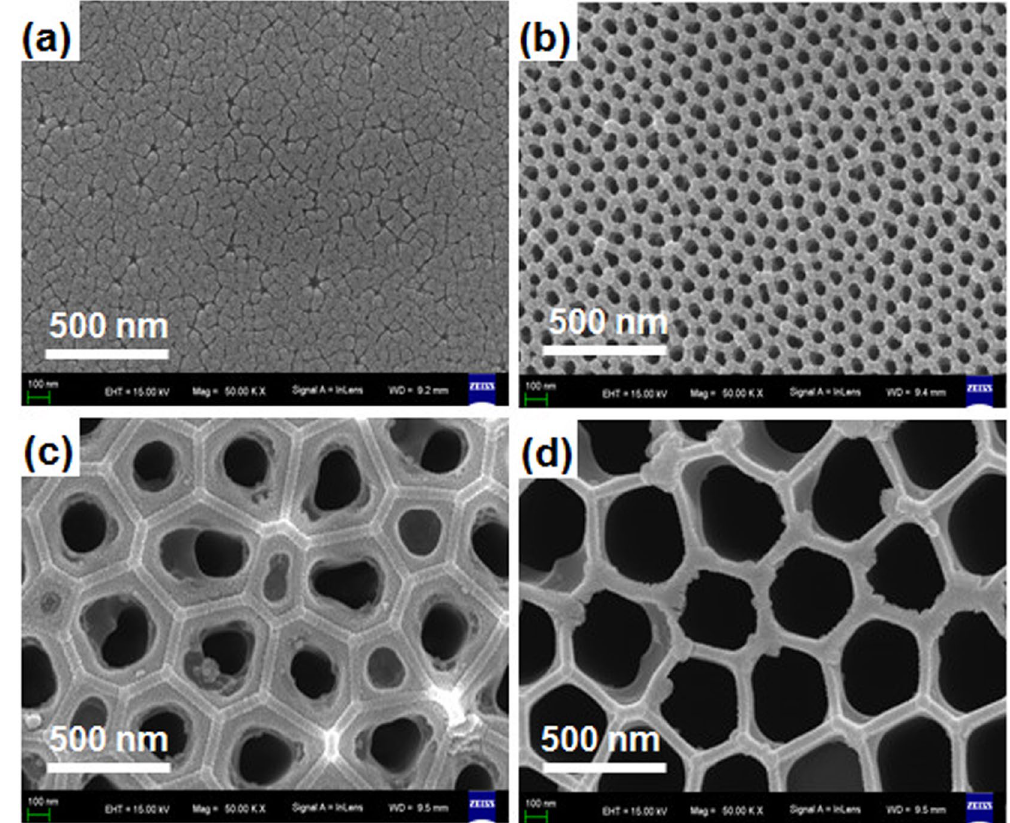
Figure 1. Top-down SEM images of the perovskite films on AAO templates with different pores in diameter: ( a ) 30, ( b ) 60, ( c ) 200, ( d ) 400 nm. In all images, scale bars are 500